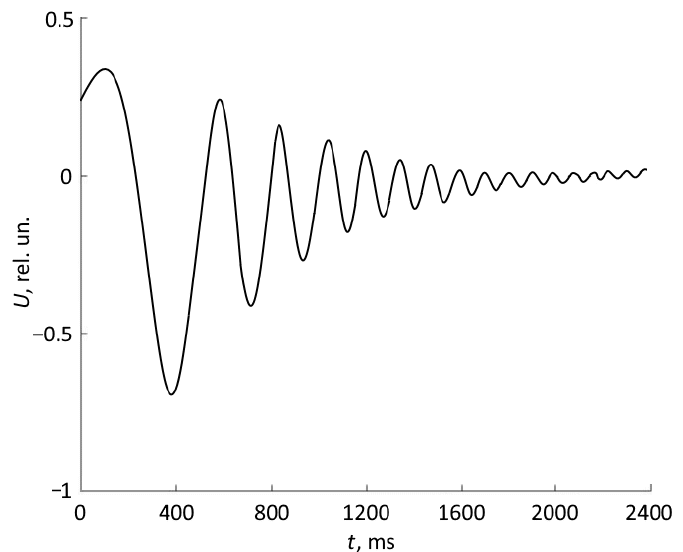
Figure 6. Dependence of the change in the amplitude U of the recorded NMR signal on time t with magnetization inversion at f n = 246103 Hz and H 1 = 18.4 A / m.